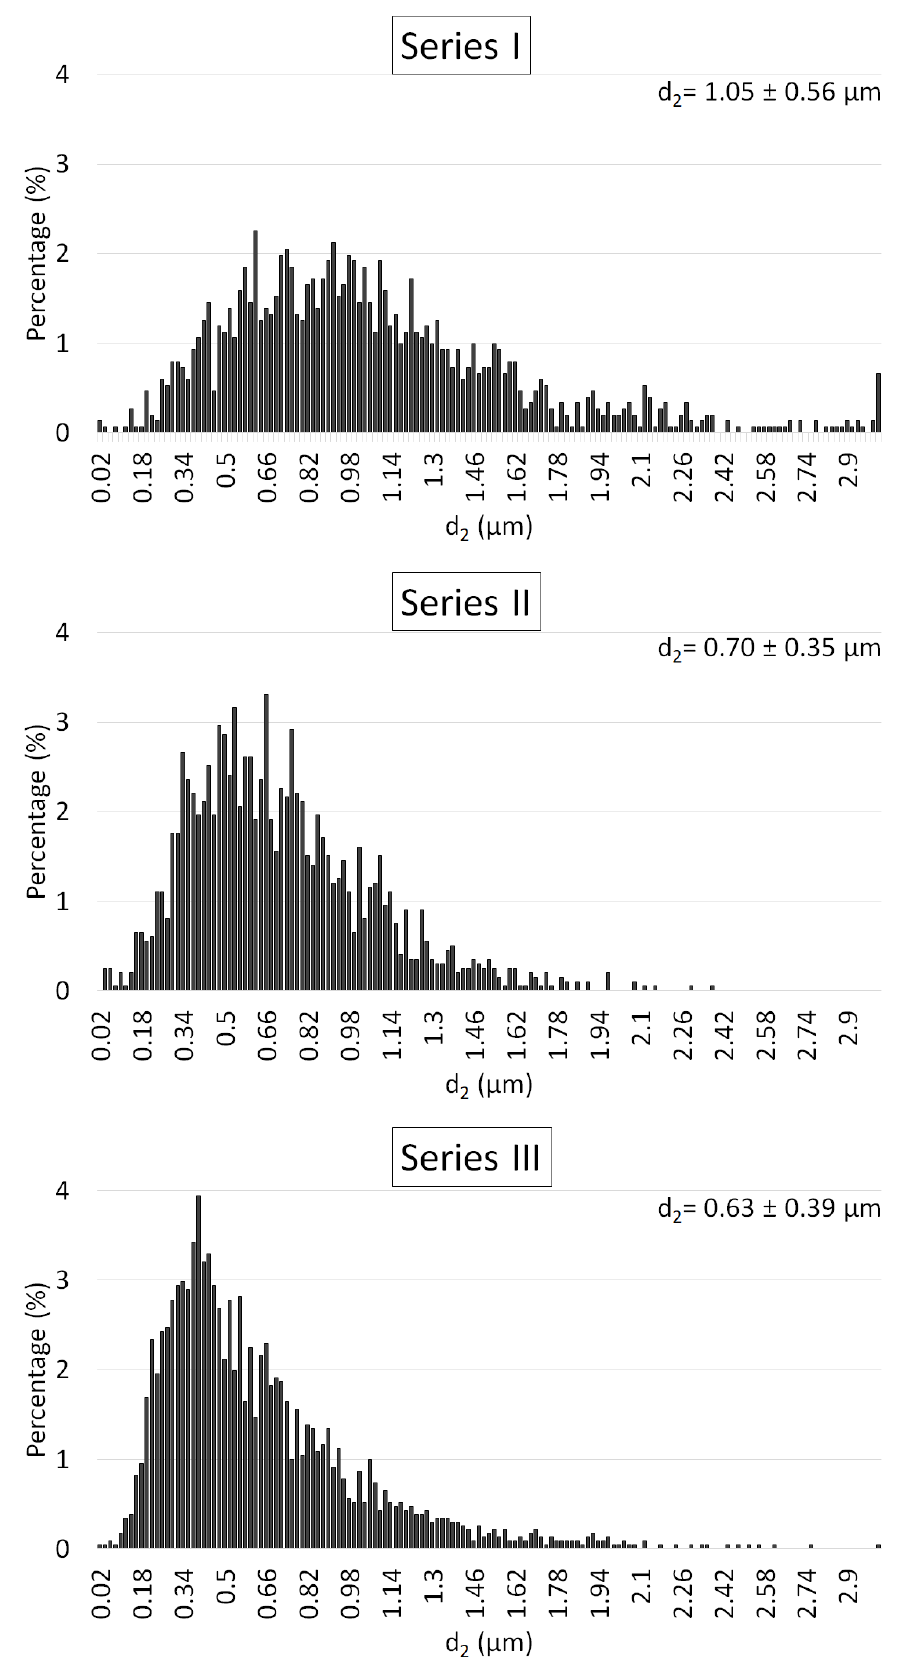
Figure 14. Histogram of the size distribution of Al 2 O 3 grain in the samples produced.